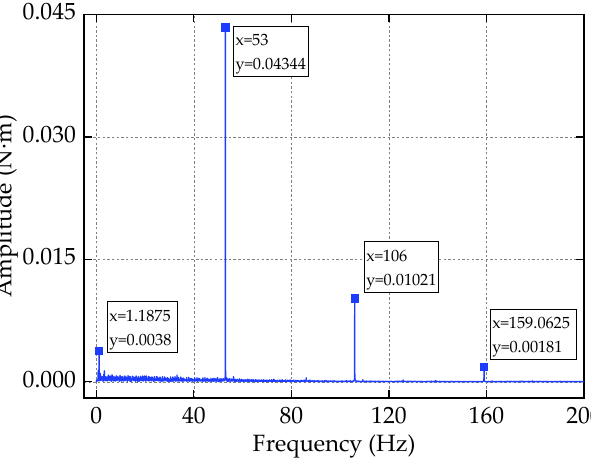
Figure 10. The frequency-domain curve of the disturbed torque.